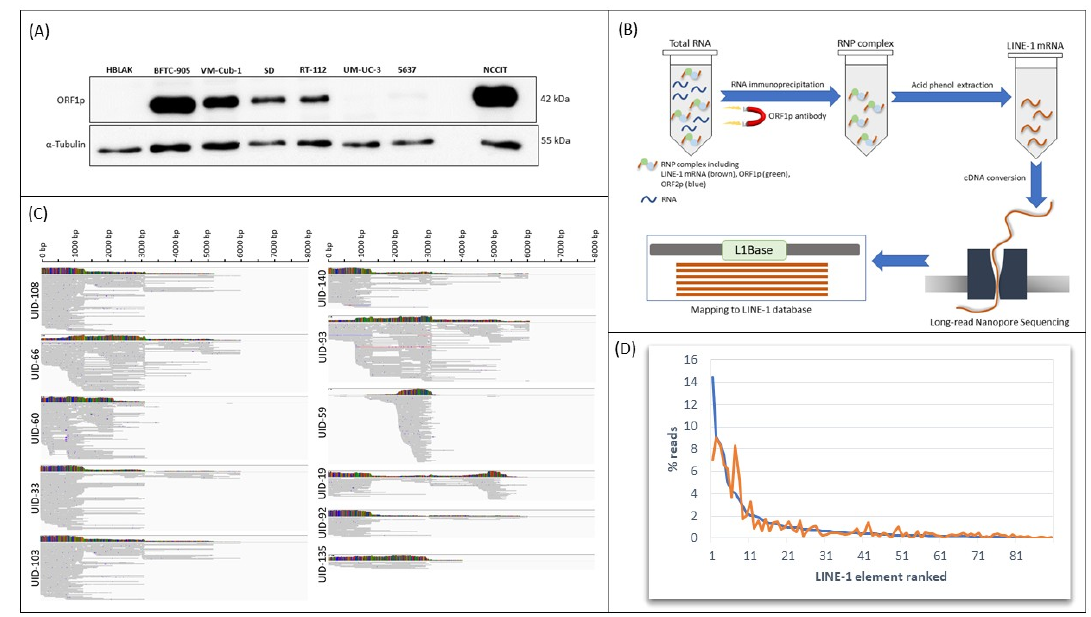
Figure 1. Comprehensive analysis of L1 expression in VM-Cub-1 UC cells. ( A ) Expression of ORF1p in representative UC cell lines analyzed by Western blotting. The non-transformed urothelial cell line HBLAK was used as a negative control and NCCIT embryonal carcinoma cells were used as a positive control. α -Tubulin was used as a loading control. ( B ) Experimental strategy to identify expression of individual L1s in bladder cancer cells. ( C ) Examples of mapping results from nanopore sequencing following RIP of VM-Cub-1 cells using the highly specific antibody against ORF1p. Read alignments are shown for the elements listed in Table 1. ( D ) Relative expression of the 90 L1 elements detected by RIP / nanopore sequencing in the two independent experiments (blue and orange) by rank.